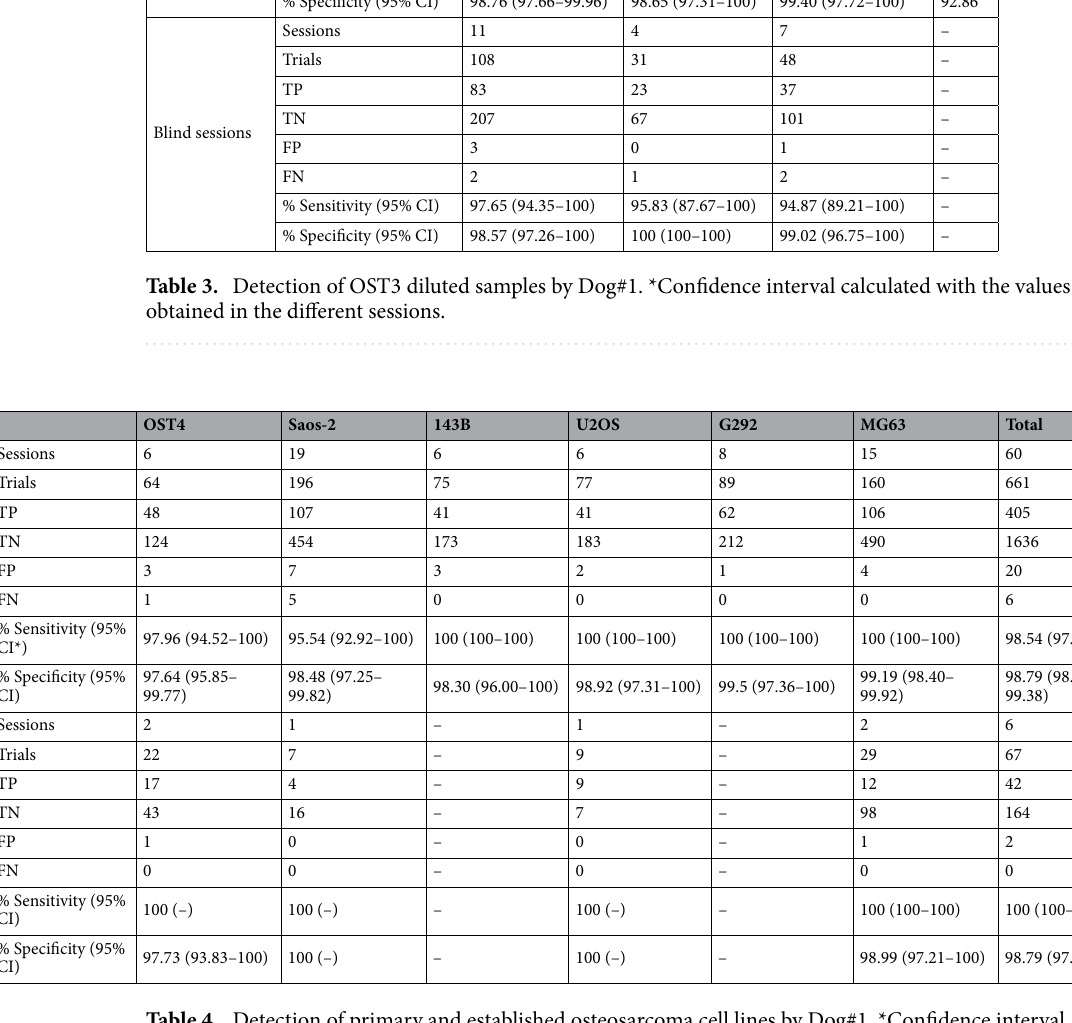
Table 4. Detection of primary and established osteosarcoma cell lines by Dog#1. *Confidence interval calculated with the values obtained in the different sessions.